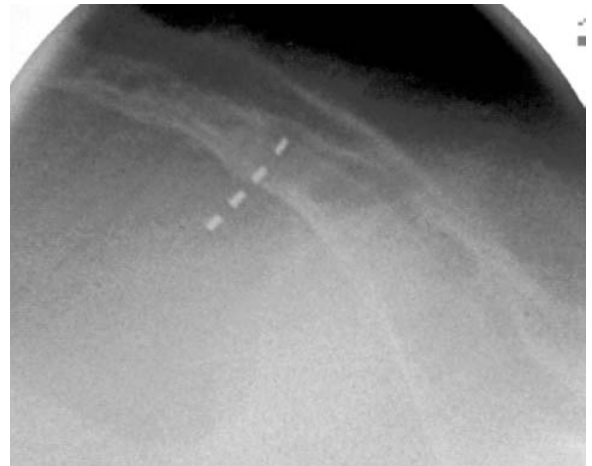
Figure 4 – Tined lead is in proper position-2-3 contact plates of the quadripole lead are resting on the S-3 dorsal root